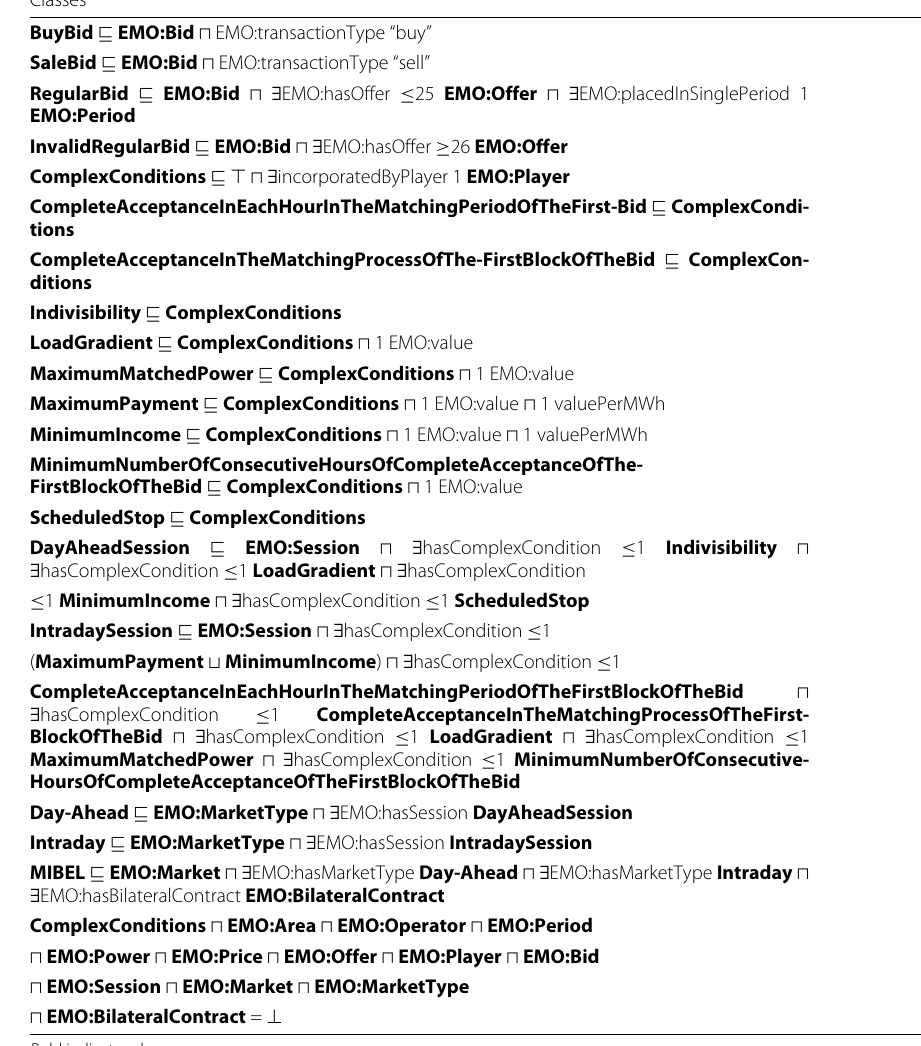
Table 3 MIBEL Ontology classes DL